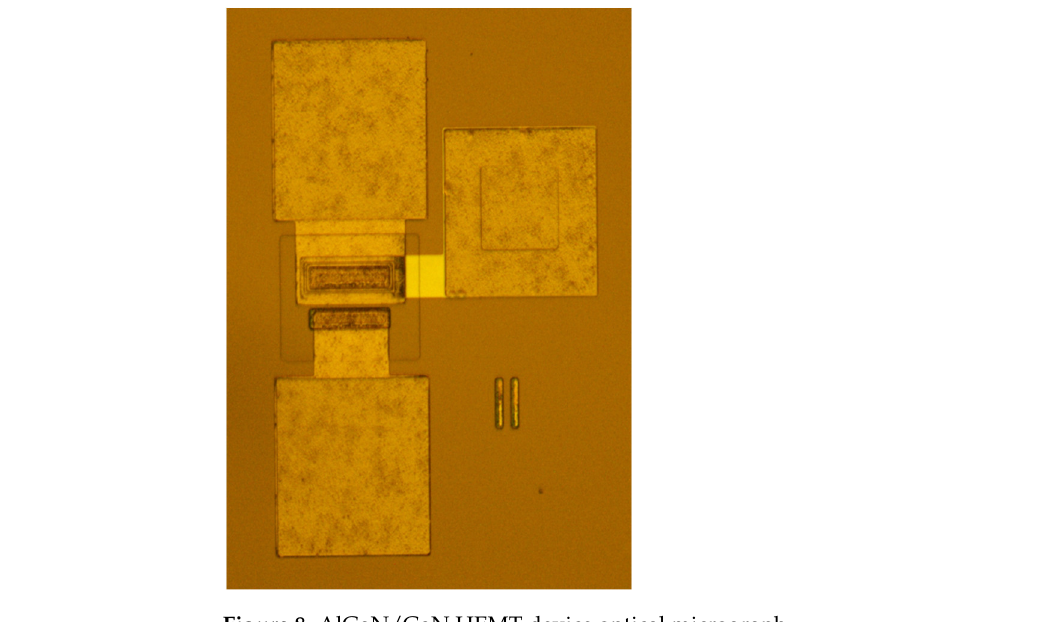
Figure 7. Fabrication flow chart of AlGaN/GaN HEMT device. ( a ), passivation: SiO 2 dep; ( b ) mesa etch; ( c ) ohmic contact; ( d ) gate trench etching; ( e ) gate metal dep; ( f ) passivation: Si 3 N 4 dep; ( g ) ohmic metal dep; ( h ) surface passivation: Si 3 N 4 dep